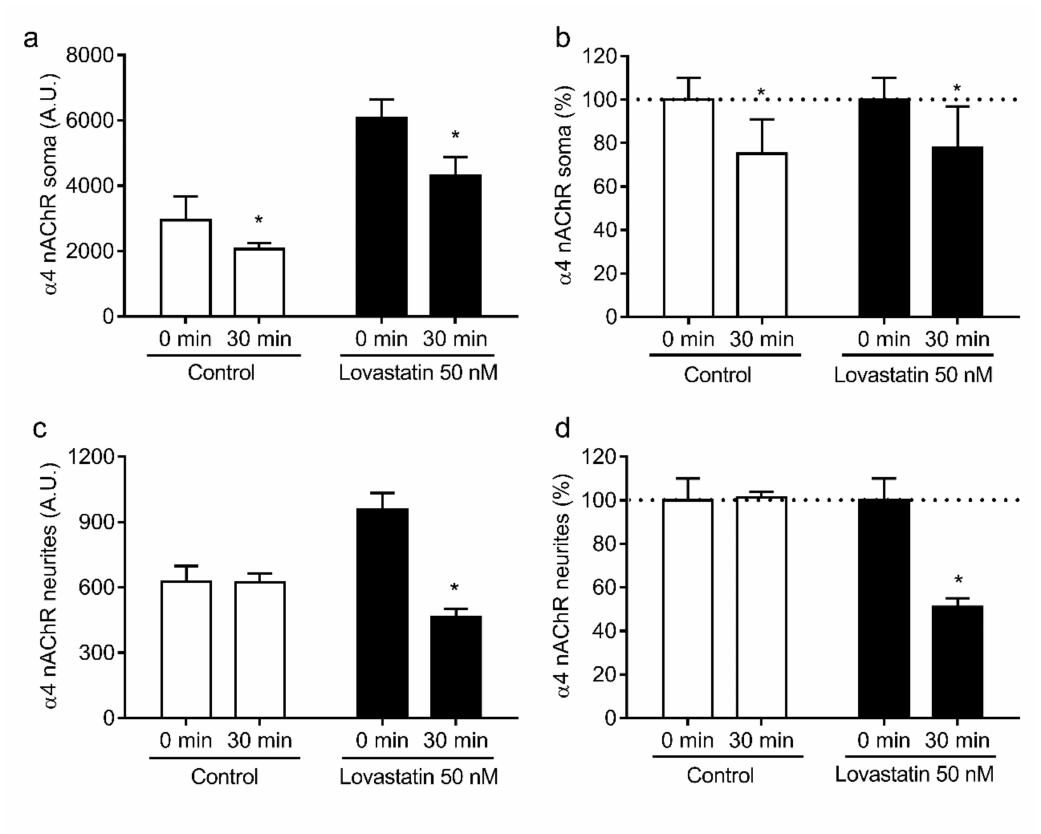
Figure 5. Lovastatin treatment a ff ects surface α 4 nAChR internalization di ff erentially in soma and neurites. Cultured hippocampal neurons were treated with 50 nM lovastatin for 14 days or left